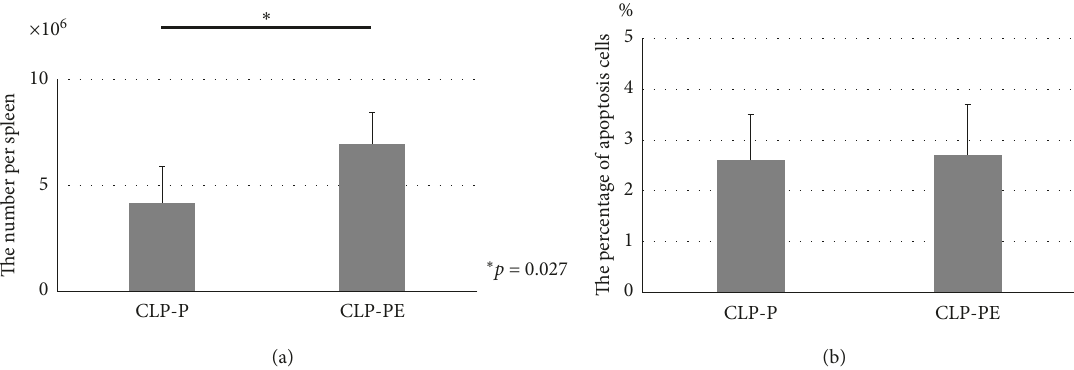
Figure 2: (a) Normal splenic T-lymphocyte numbers in CLP (proximal site) mice with (CLP-PE) or without (CLP-P) beta-blocker therapy. Beta-blocker therapy restored the normal T-lymphocyte numbers reduced by CLP. (b) The percentage of T-lymphocyte apoptosis in the CLP-P and CLP-PE groups. There was no significant difference in the percentage of apoptosis between the two groups. CLP-P: the group which underwent proximal site CLP; CLP-PE: the group which received beta-blocker therapy after proximal site CLP. Table 1: The percentage of CD4+ and CD8+ cells in control and esmolol groups.